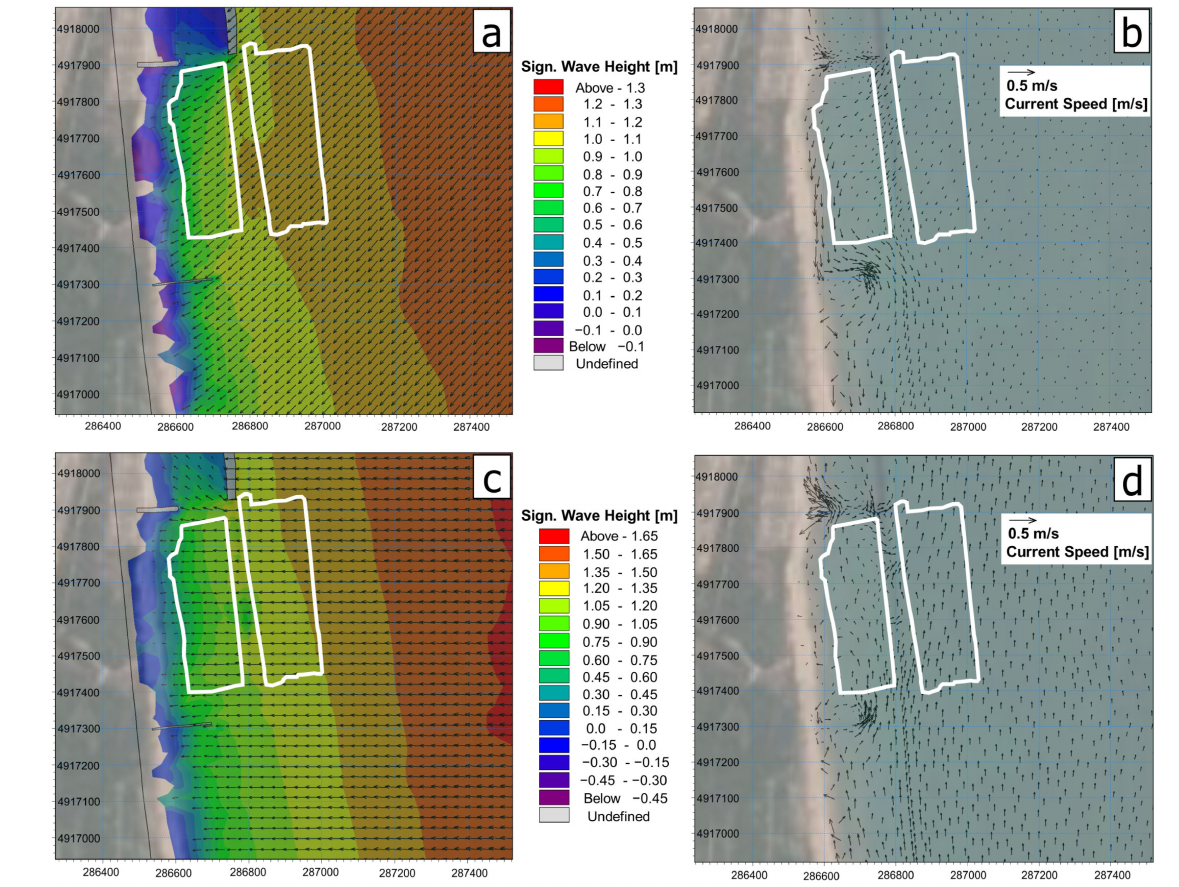
Figure 13. Wave and current fields modeled for conditions corresponding to storms from the NE ( a , b ) and SE ( c , d ). White boxes delimit the study area.